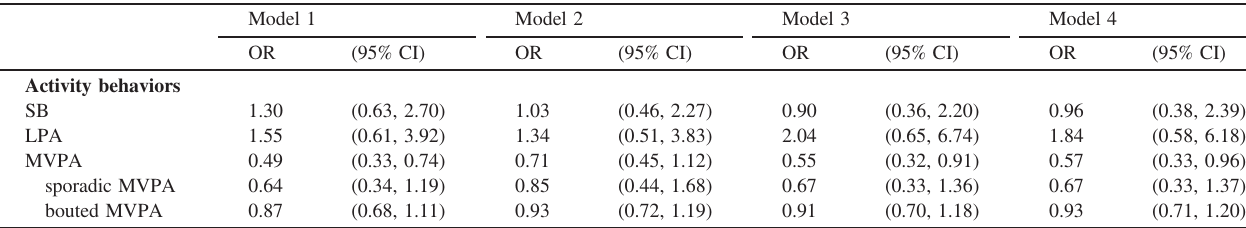
Figure 1. Composition of the day by cognitive status. Compositional analysis of the relative importance of the group mean time spent in SB, LPA and MVPA with respect to the overall mean time composition. In the left axis presents the log-ratio value and the right axis displays the actual proportion relative to the mean composition (eg, 1.053 means 1.053 times the compositional mean or a proportion higher by 5.3%). LPA, light-intensity physical activity; MVPA, moderate-to-vigorous physical activity; SB, sedentary behavior. Table 3. Associations of sedentary and physically-active behaviors with cognitive function in older